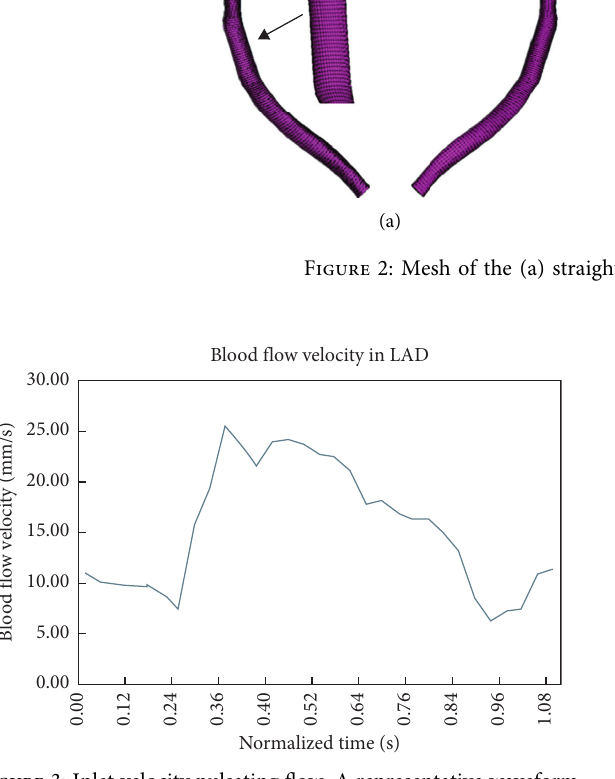
Figure 3: Inlet velocity pulsating flow. A representative waveform describing the average blood flow velocity measured in the proximal portion of a human left anterior descending coronary artery during a cardiac cycle. This waveform was used to complete the time-dependent simulations in the present study.